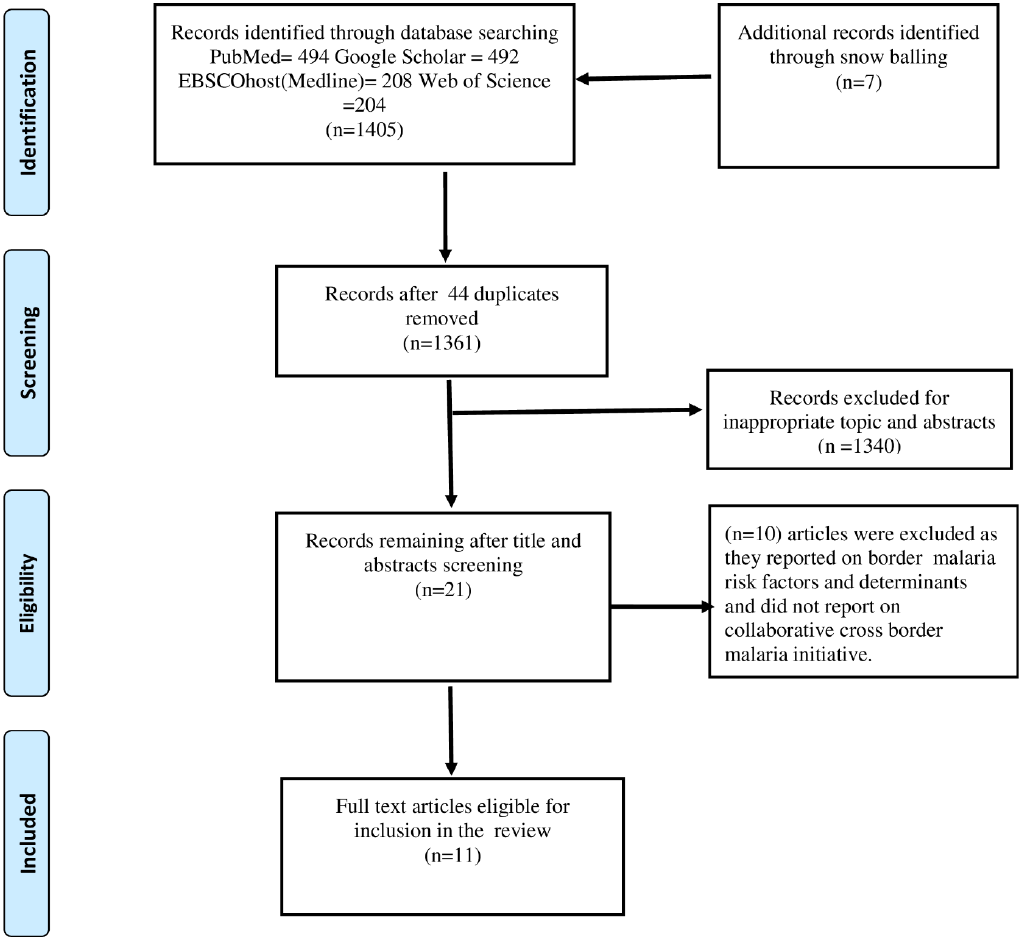
Figure 1. Preferred Reporting Items for Systematic Reviews and Meta-Analyses (PRISMA) flow diagram showing process of article selection.